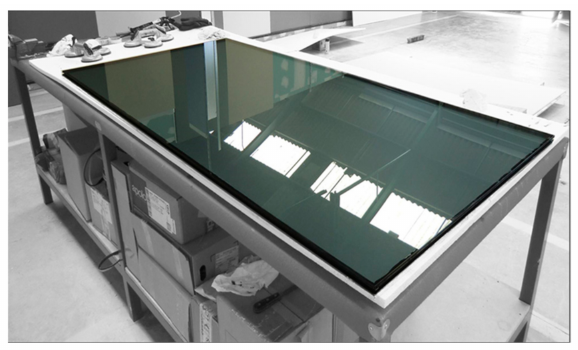
Figure 8. Prototypes of a collector ceramic panel. Reproduced with permission from [3].